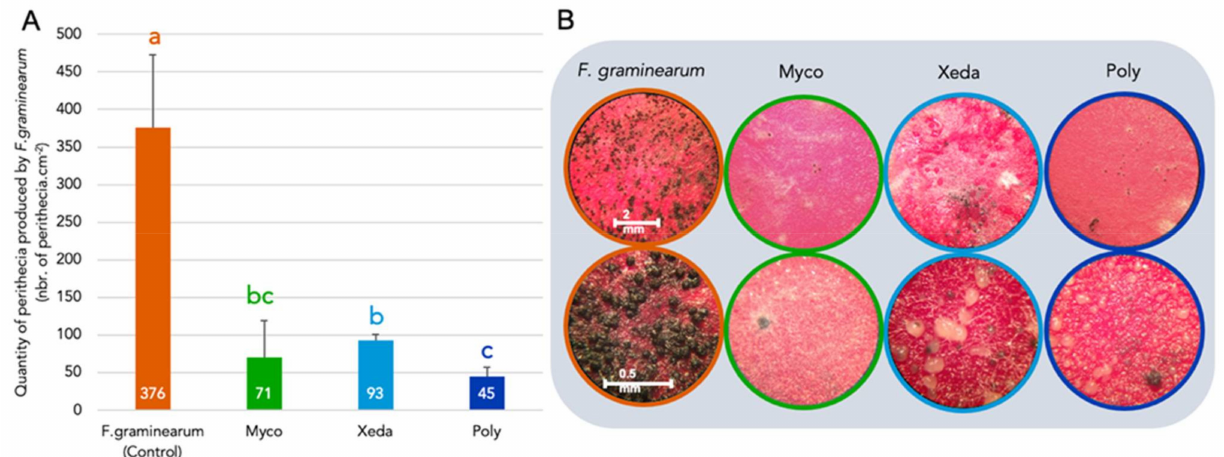
Figure 11. Effect of BCAs on perithecia production of F. graminearum . A. Quantity of perithecia produced by F. graminearum on carrot agar after 6 days of contact with BCAs at 22 ◦ C, B. Visual aspect of treated or control perithecia test, microscopic im- ages were taken with binocular loupe ( × 20 and × 150 enlargement). Myco: Mycostop ® , Xeda: Xedavir ® , Poly: Polyversum ® . ANOVA test, p -value <